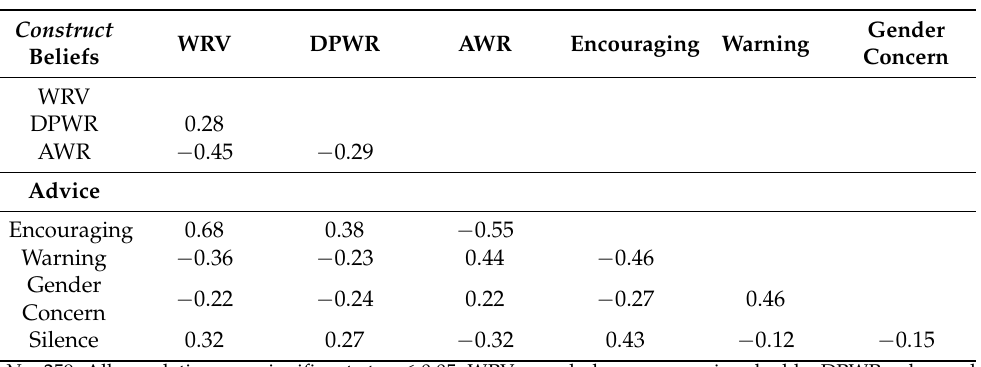
Table 3. Correlation between constructs